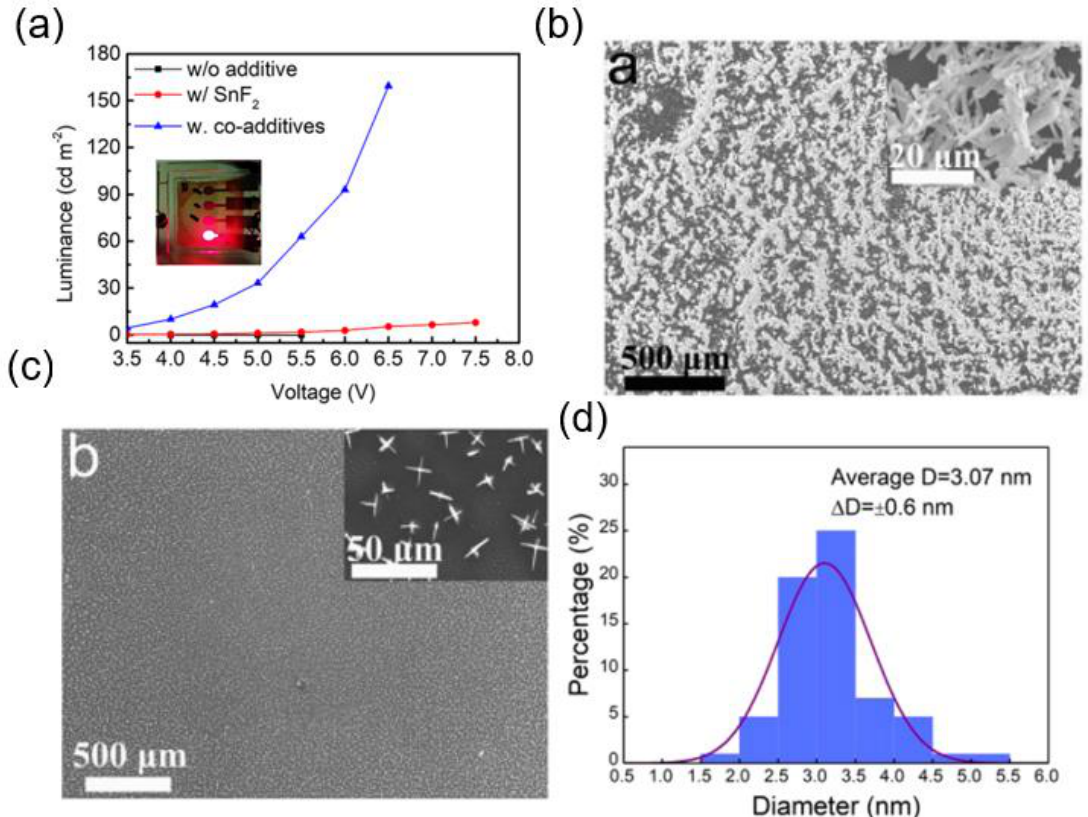
Figure 20. ( a ) Luminance voltage of CsSnBr 3 [103]. Copyright 2022, American Chemical Society ( b ) SEM image of Cs 3 Cu 2 Br 5 Micro rods [105]. ( c ) SEM image of CsCuBr 2 Micro crosses [105]. ( d ) Size distribution analysis for colloidal Cs 3 Sb 2 Br 9 [107]. Copyright 2017, American Chemical Society.